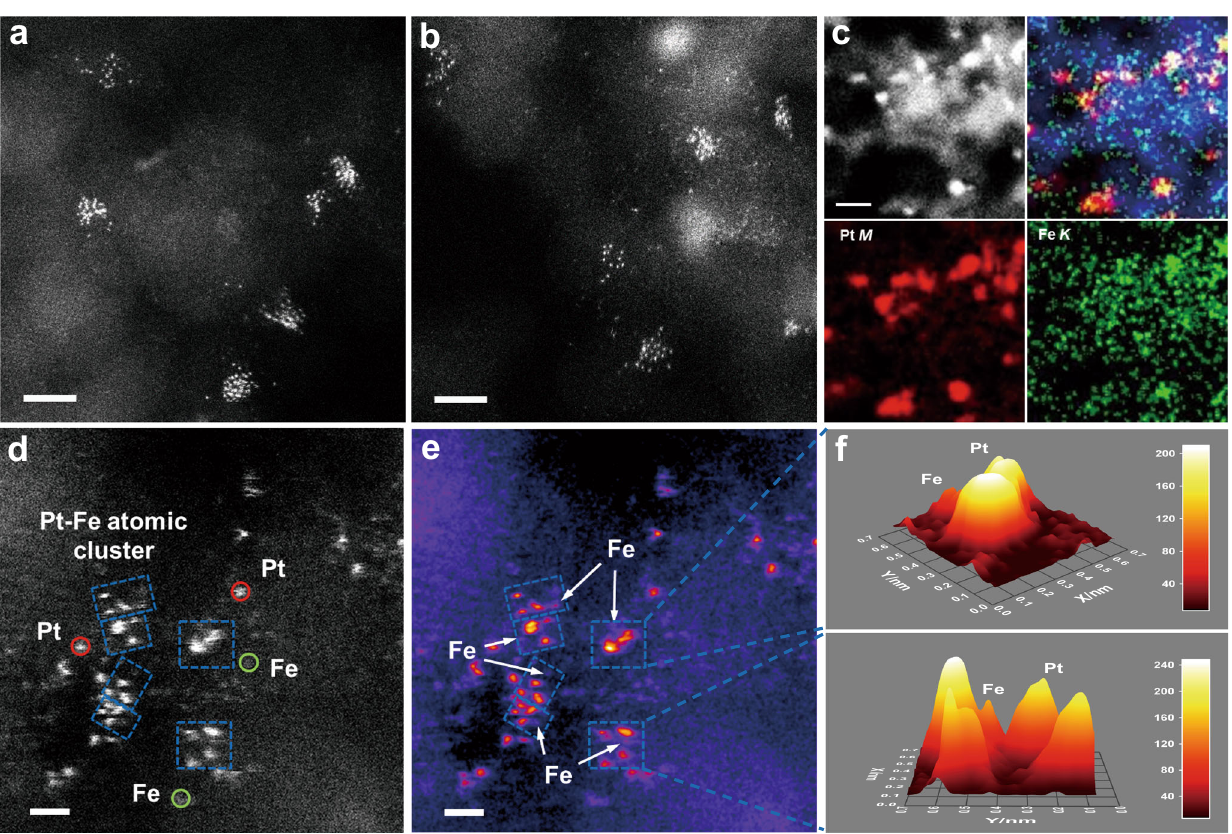
Fig. 1 | Microscopic structures of 0.75Pt0.2Fe/ND@G. a , b HAADF-STEM images of 0.75Pt0.2Fe/ND@G at high magni fi cation. c Energy-dispersive X-ray (EDX) mapping images of 0.75Pt0.2Fe/ND@G catalyst. d , e The high resolution HAADF- STEM image of the 0.75Pt0.2Fe/ND@G, where representative isolated Pt, Featoms